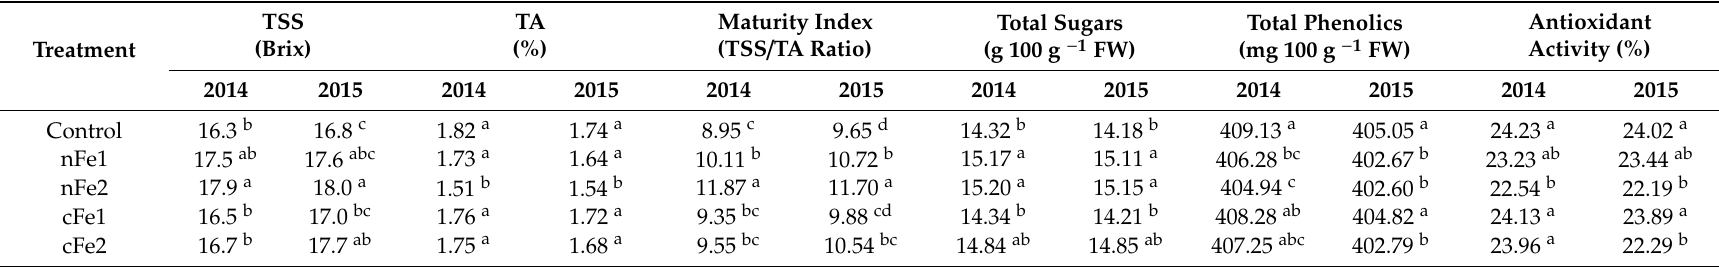
Table 2. E ff ect of foliar fertilization with FeSO 4 (nFe) and Fe(III)-EDDHA (cFe) on pomegranate fruit total soluble solids (TSS), titratable acidity (TA), maturity index, total sugars, total phenols and antioxidant activity in 2014 and